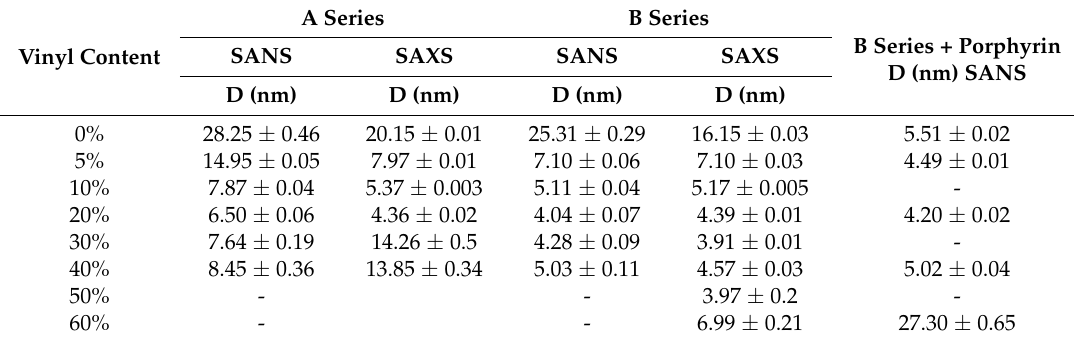
Table 3. SANS and SAXS fitting